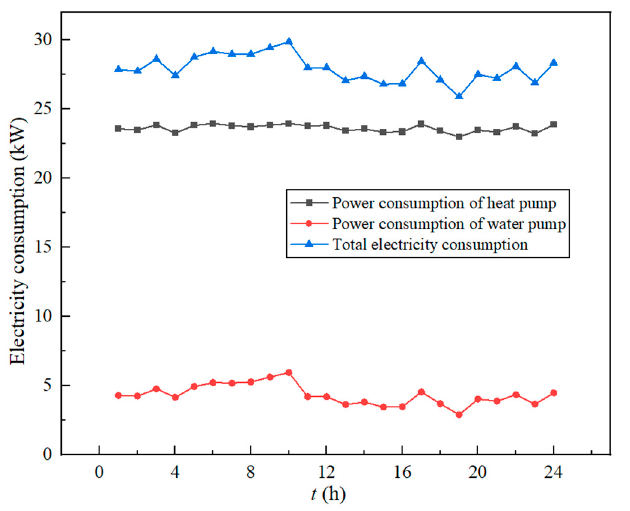
Figure 11. Electricity consumption in each period when the objective function is system COP.